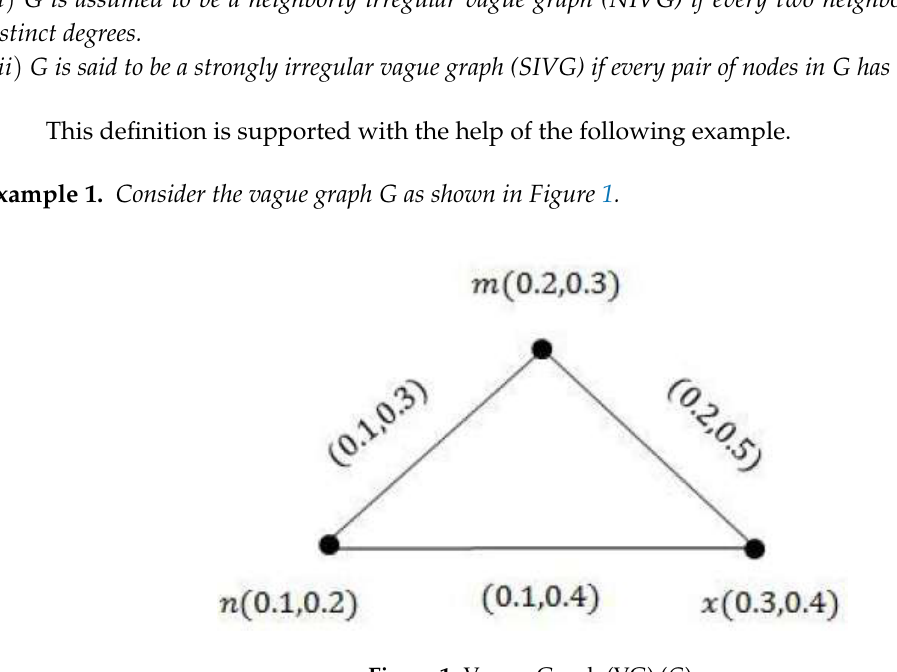
Figure 1. Vague Graph (VG) ( G